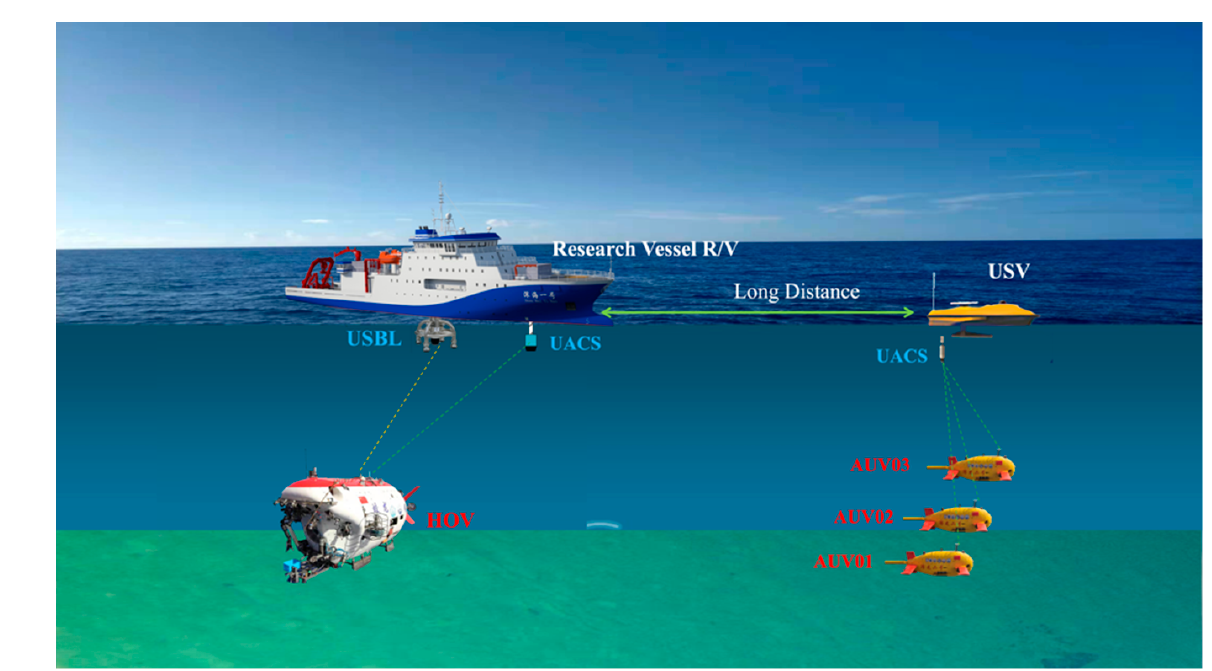
Figure 6. A scenario of cooperative operation based on USVs.